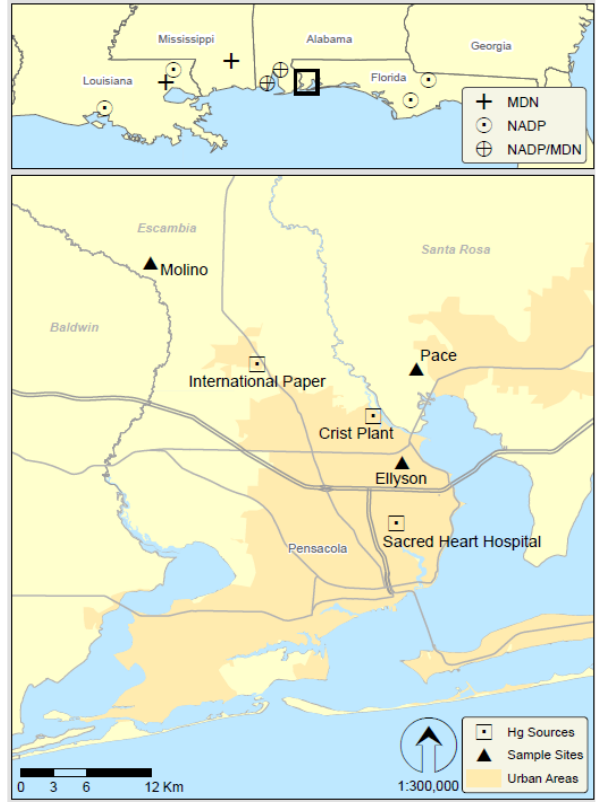
Fig. 1. Rainfall sampling sites and atmospheric Hg sources in the Pensacola, Florida area. NADP sites are part of the National Acid Deposition Program; MDN sites are part of the NADP Mercury De- position